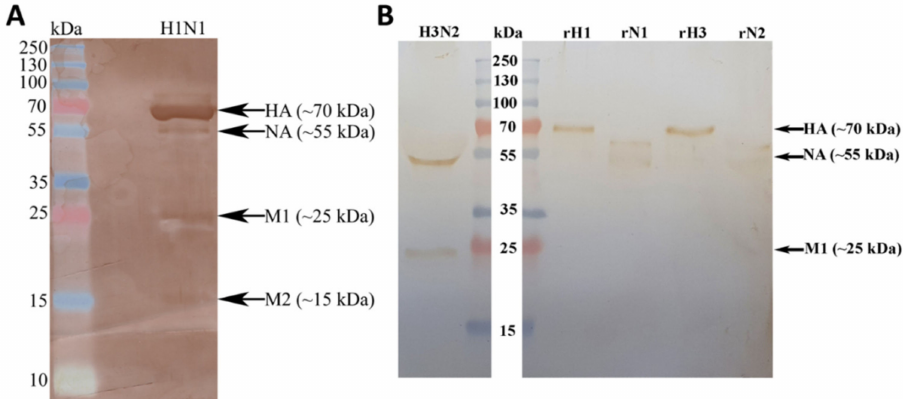
Figure 2. Far-Western blotting analysis to assess C1q binding to individual IAV proteins in the virus lysate, or purified H1N1 ( A ) and H3N2 ( B ). H1N1 and H3N2 virus lysates, or recombinant IAV glycoproteins (5 µ g/mL) were separated using SDS-PAGE (12% w / v ) under reducing conditions, and then transferred onto an activated PVDF membrane. Following blocking with PBS + 5% w / v BSA, the membrane was incubated with 20 µ g/mL of C1q. After PBS washes, the membrane was probed with rabbit anti-human C1q antibody (1:1000). C1q bound M1 (~25 kDa), HA (~70 kDa) and NA (~55 kDa) of both IAV subtypes. C1q was also found to bind to the M2 protein of H1N1 alone.